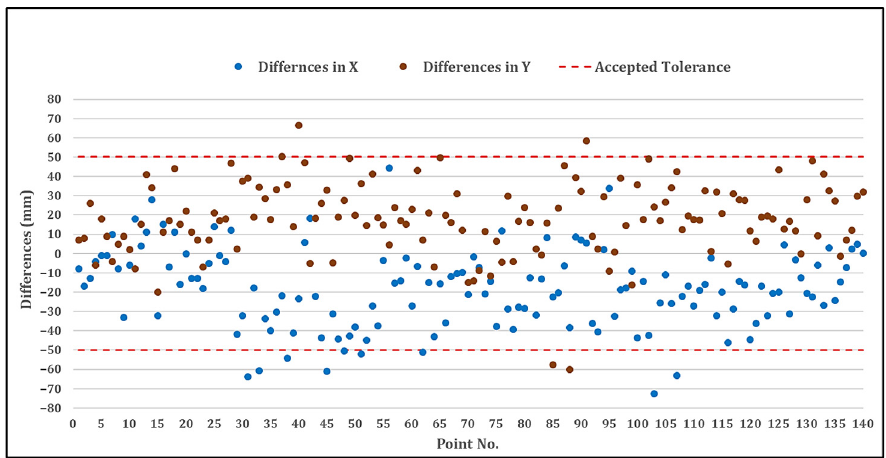
Figure 12. Differences between the extracted points by the proposed method and total station coordinates on the X and Y axes of the second test.